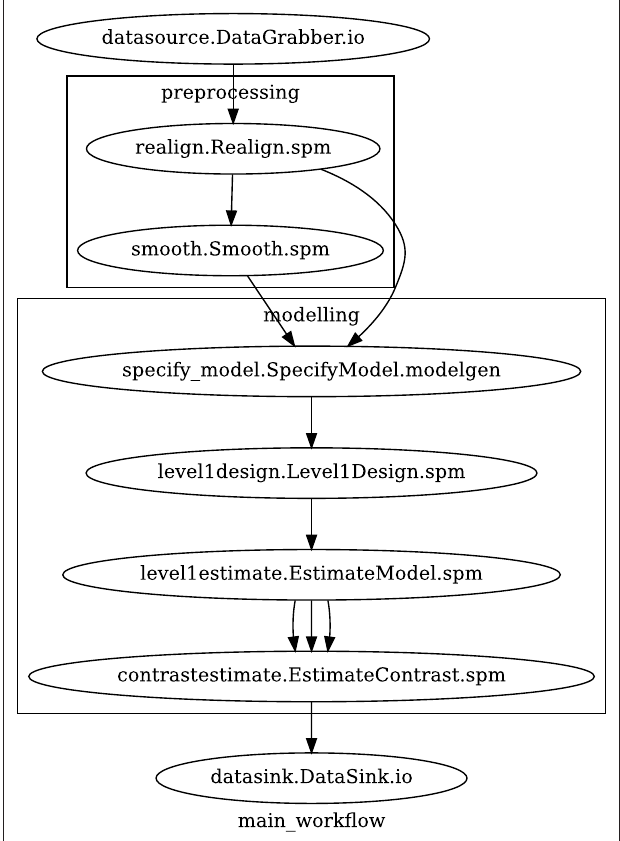
FiGure 3 | Graph depicting the processing steps and dependencies for a first level functional analysis workflow. Every output–input connection is represented with a separate arrow. Nodes from every subworkflow are grouped in boxes with labels corresponding to the name of the subworkflow. Such graphs can be automatically generated from a Workflow definition and provide a quick overview of